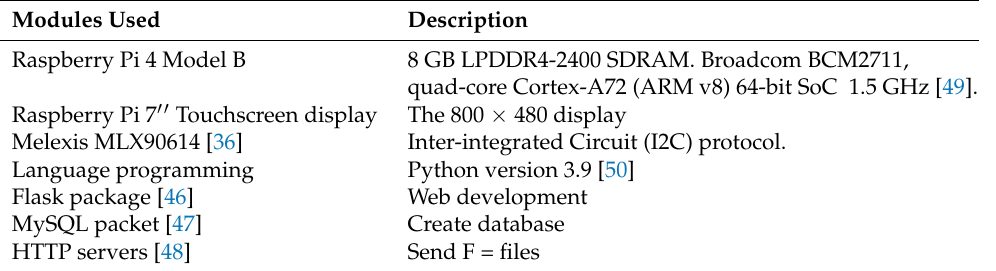
Table 2. Equipment using the attendance